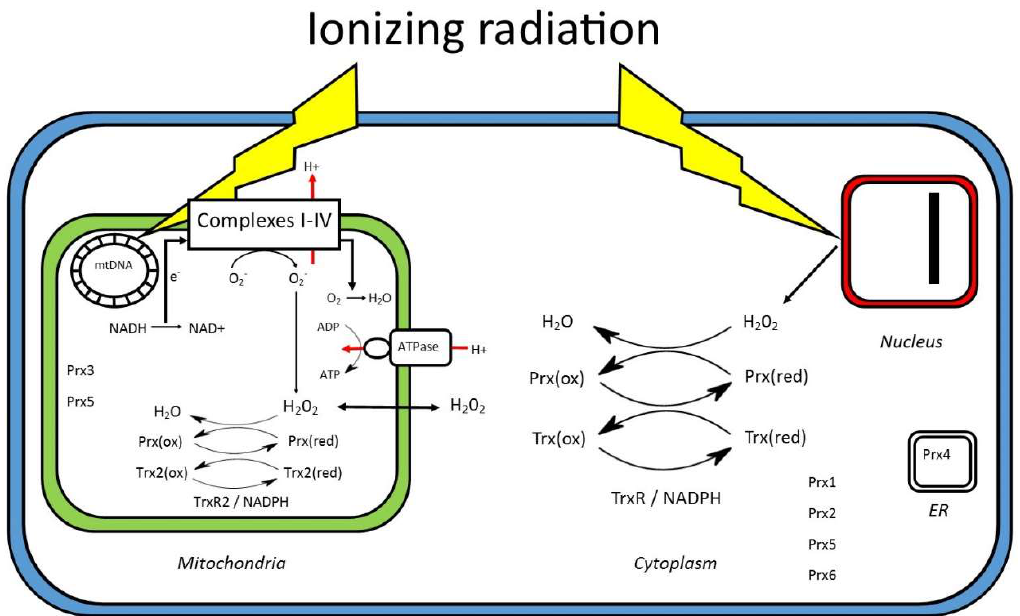
Figure 1. Overview of disrupted redox homeostasis and peroxiredoxin activity following the exposure of cells to ionizing radiation.